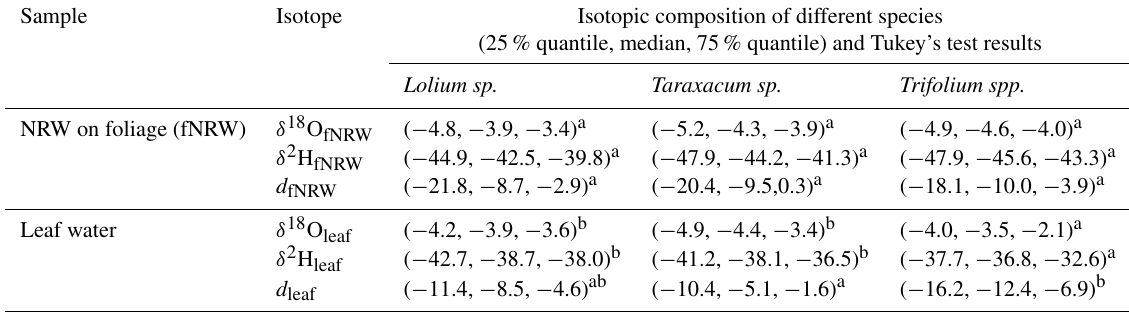
Table 2. Variability of the isotopic composition among species for non-rainfall water on foliage and leaf water. The 25% quantile, median, and 75% quantile are shown.